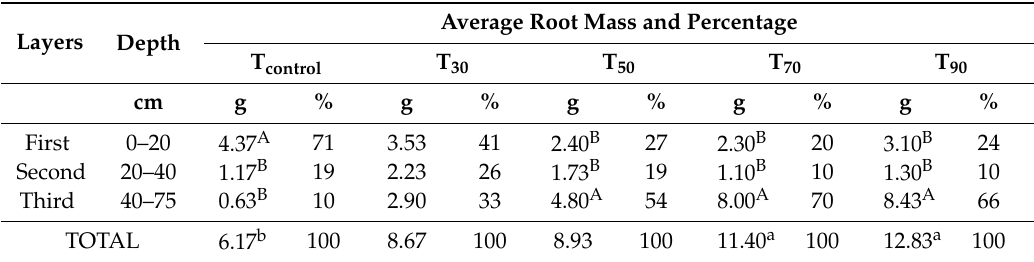
Table 5. Average root mass and proportions for each layer of the treatments. Average Root Mass and Layers Depth